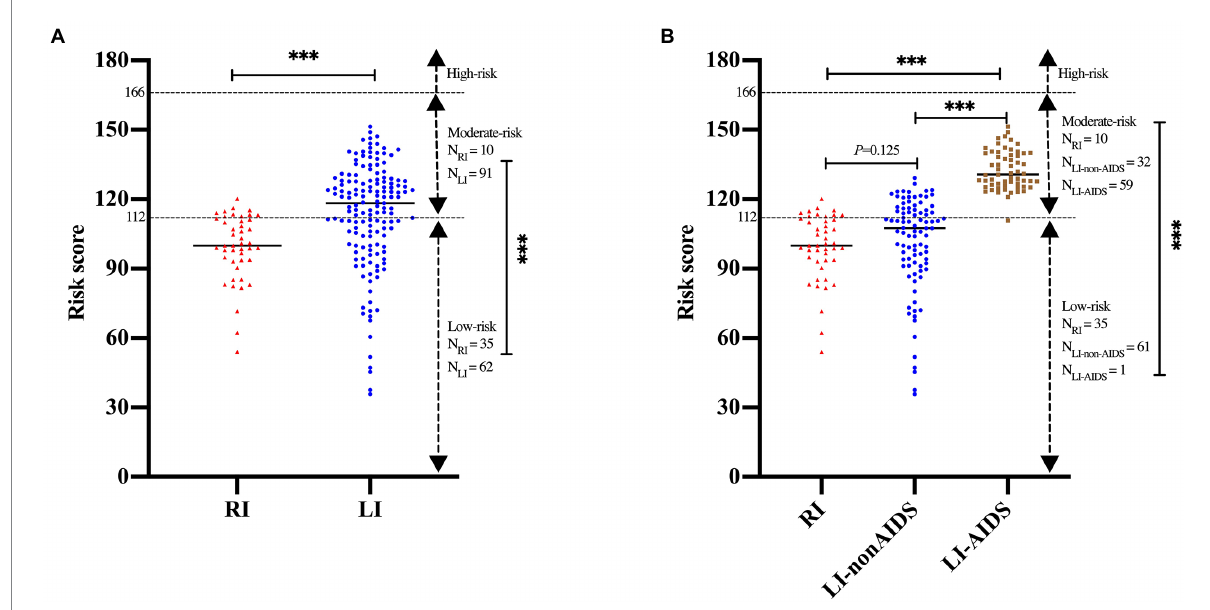
FIGURE 6 Prognostic risk scores of recent and long-term HIV-1 infection patients. The prognostic scores were calculated to predict mortality using Wenzhou model and were categorized into three risk groups: low (<112), moderate (112 ∼ ) and high ( ≥ 166) according to the previous studyies (Hou et al., 2019; Wang et al., 2020). (A) The prognostic risk scores for HIV-1 patients of recent and long-term infection. (B) The prognostic risk scores for HIV-1 patients of recent and long-term infection with or without AIDS. *, p < 0.05; **, p < 0.01; ***, p <